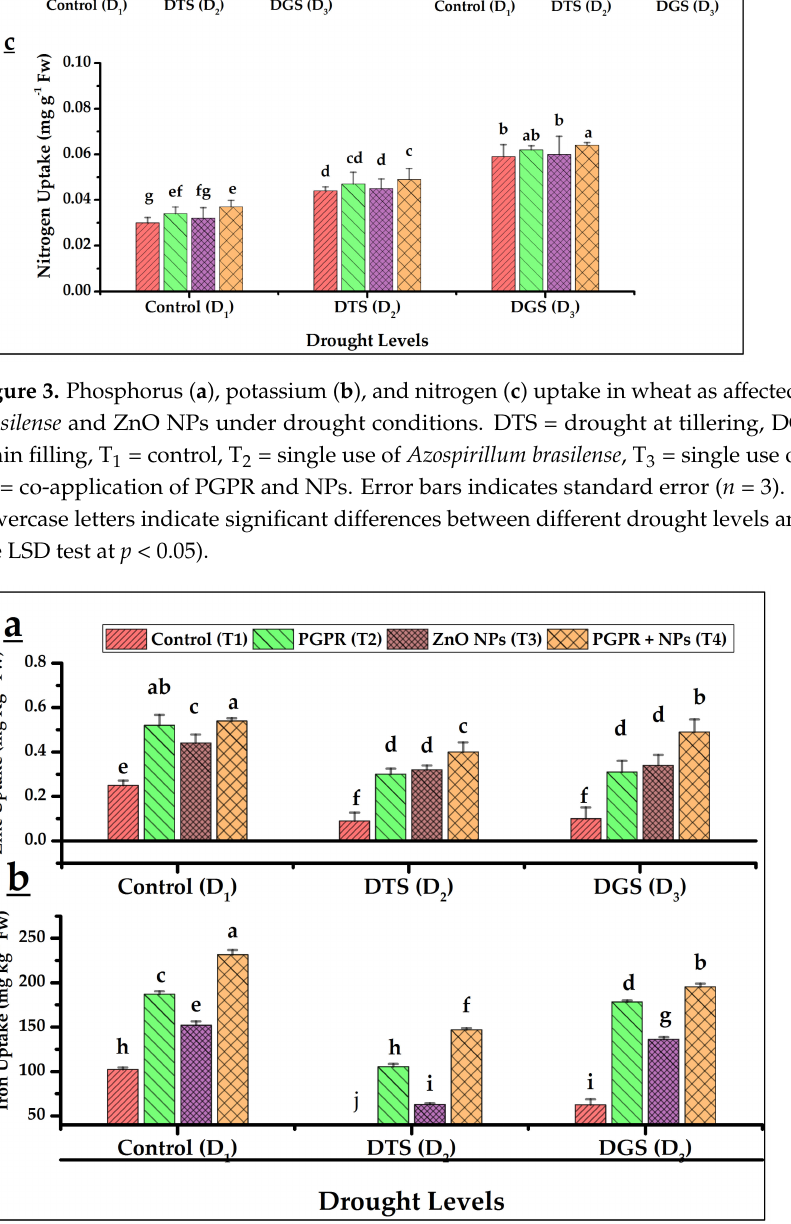
Figure 4. Effects of PGPR and ZnO NPs on zinc ( a ) and iron ( b ) uptake in wheat under different drought levels. DTS = drought at tillering, DGS = drought at grain filling, T 1 = control, T 2 = single use of Azospirillum brasilense , T 3 = single use of ZnO NPs, and T 4 = co-application of PGPR and NPs. Error bars indicates standard error ( n = 3). (Note: Different lowercase letters indicate significant differences between different drought levels and treatments by the LSD test at p <